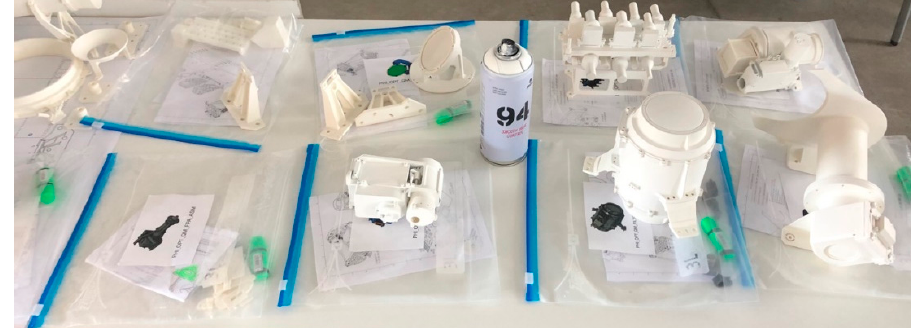
Figure 1. Classification and labelling of SO/PHI sub-assemblies.